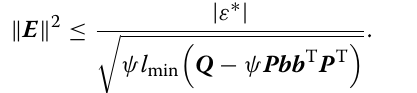
) represents the eigenvalue of the matrix. where l min ( · If the derivative of the Lyapunov function is less than zero, then Eq. (49) must be satisfied.